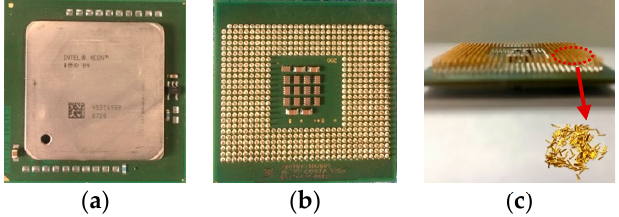
Figure 9. The waste CPU utilized for the gold leaching: ( a ) backside; ( b ) front side; ( c ) CPU chips. Reaction condition: 0.01 g CPU pins dissolved in 3 g N 4441 Cl and 0.3 g TCCA in 5 mL acetone within 10 min.